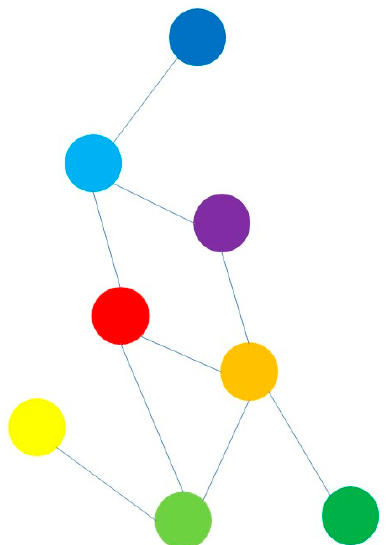
Figure 1. A toy food web for illustration. The dark blue and the yellow nodes are top-predators and the light green and dark green nodes are the producers. The direction of carbon flows is not shown (from the bottom upwards) for simplicity.